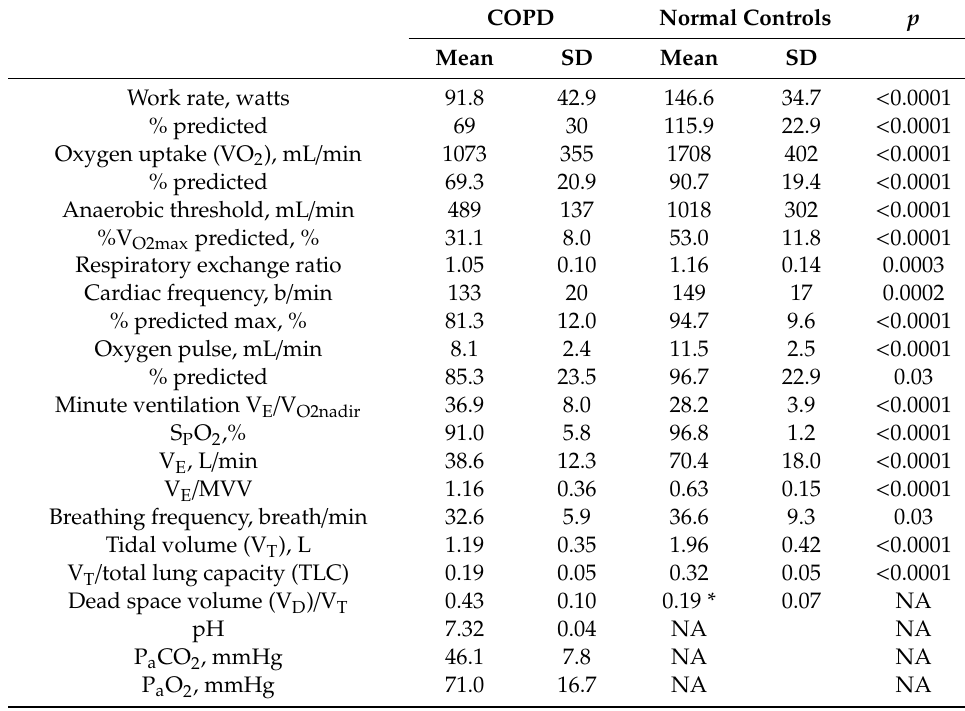
Figure 1. Flow diagram. A total of 81 participants with chronic obstructive pulmonary disease and healthy controls were screened. Table 2. Cardiopulmonary exercise test at peak exercise in male subjects with chronic obstructive pulmonary disease (COPD) ( n = 46) and male healthy subjects ( n = 34).